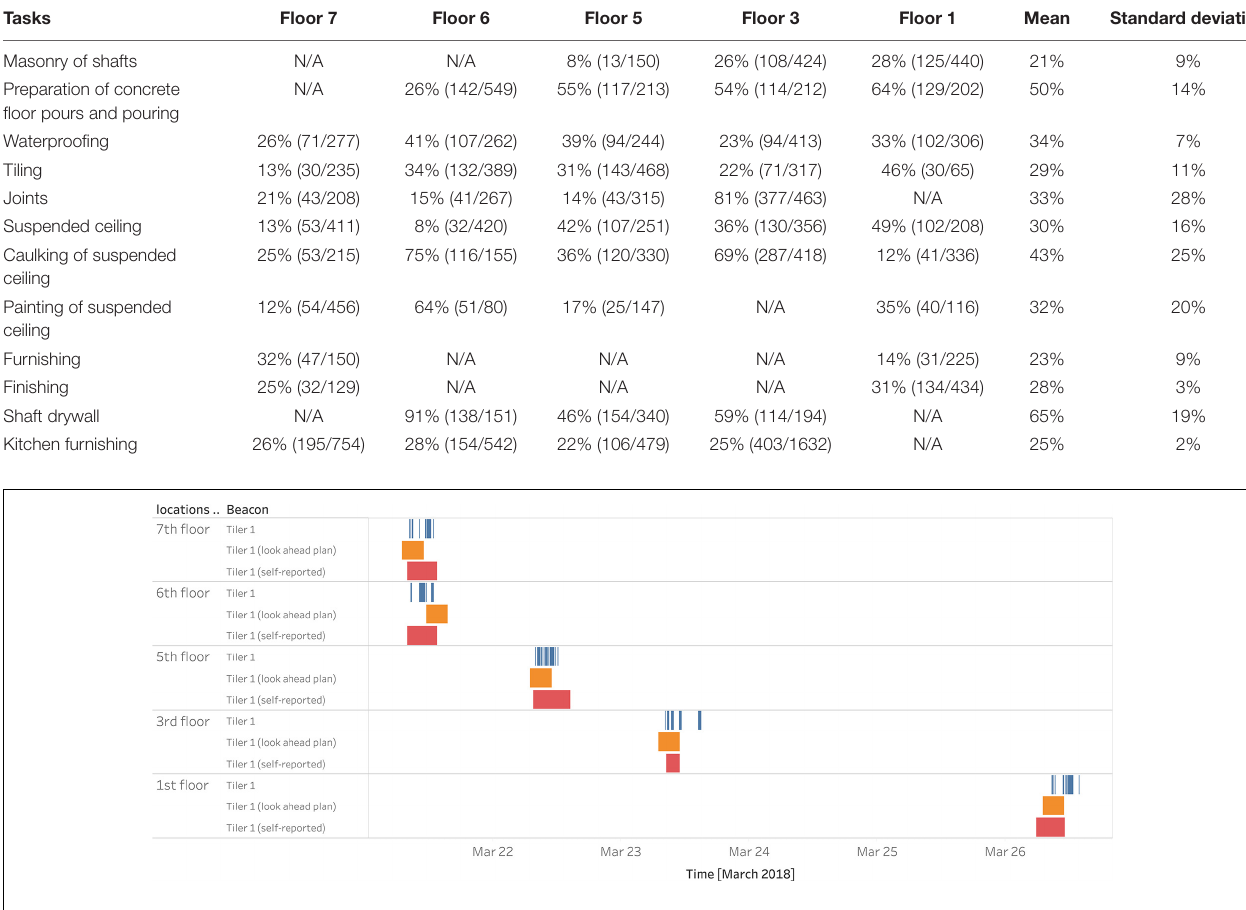
TABLE 6 | Task-level presence indices of the workers on each floor and on average (uninterrupted presence time during task / actual duration of the task).